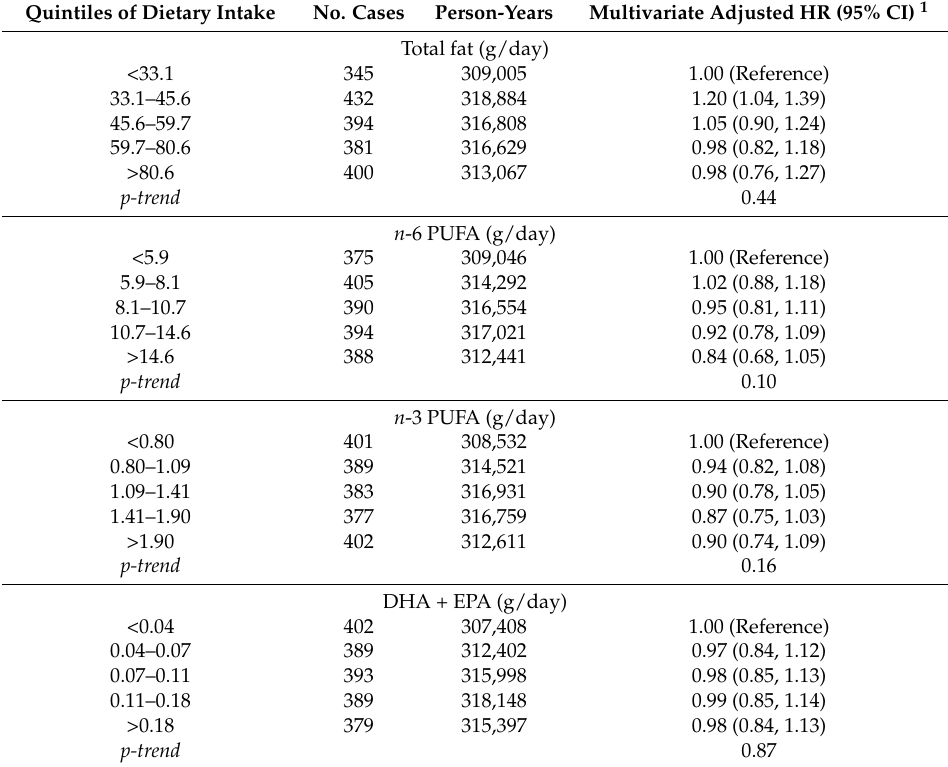
Table 3. Multivariate-adjusted hazard ratios and 95% CIs for the association of fat with colorectal cancer in the Women’s Health Initiative ( n = 134,017)